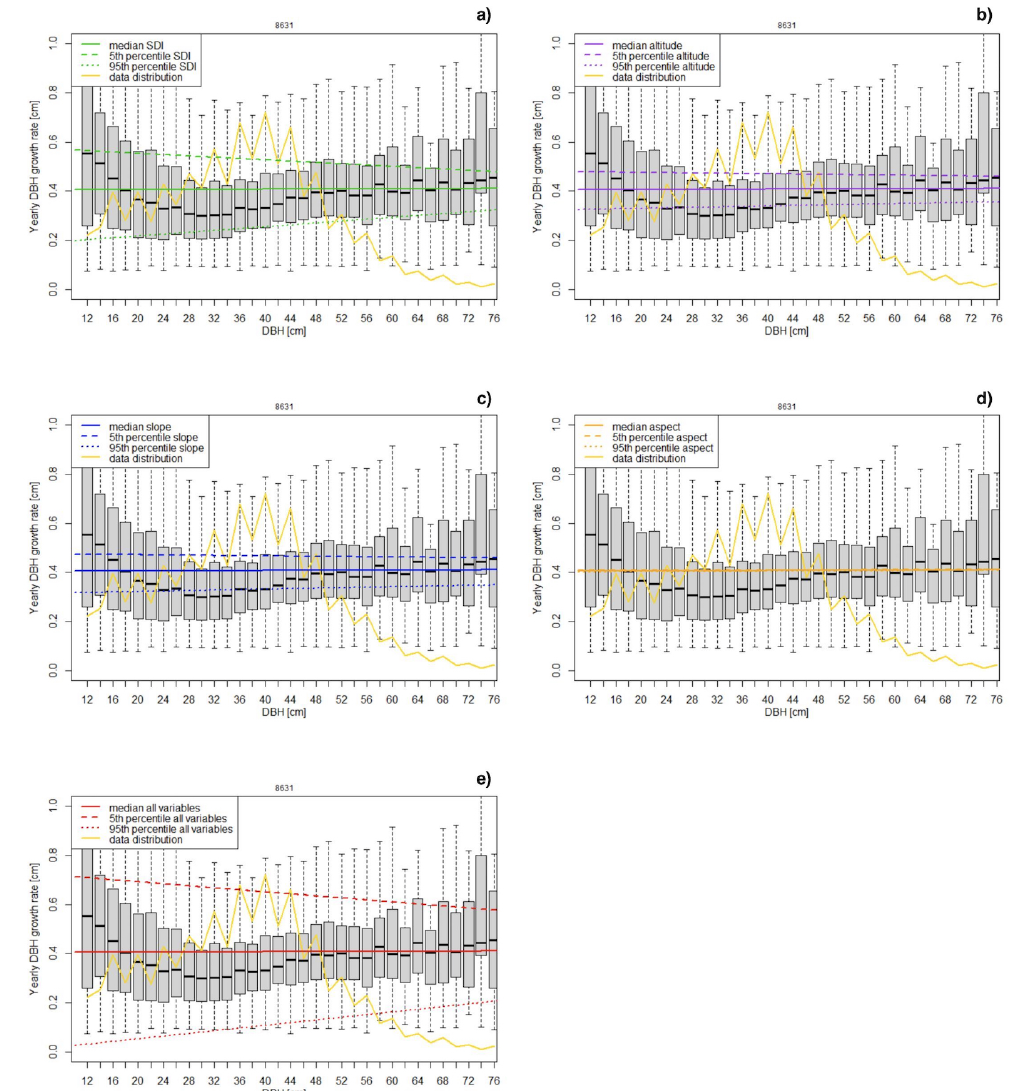
Figure 2. Sensitivity analysis of the linear growth rate model. The data are presented in 2 cm DBH classes from 0.12 m up to 0.76 m. For each parameter, model predictions using median values for predictors and their 90th percentile interval are shown: ( a ) SDI, ( b ) altitude, ( c ) slope, ( d ) aspect, ( e ) all variables. The yellow line shows the percent frequency of data included in each DBH